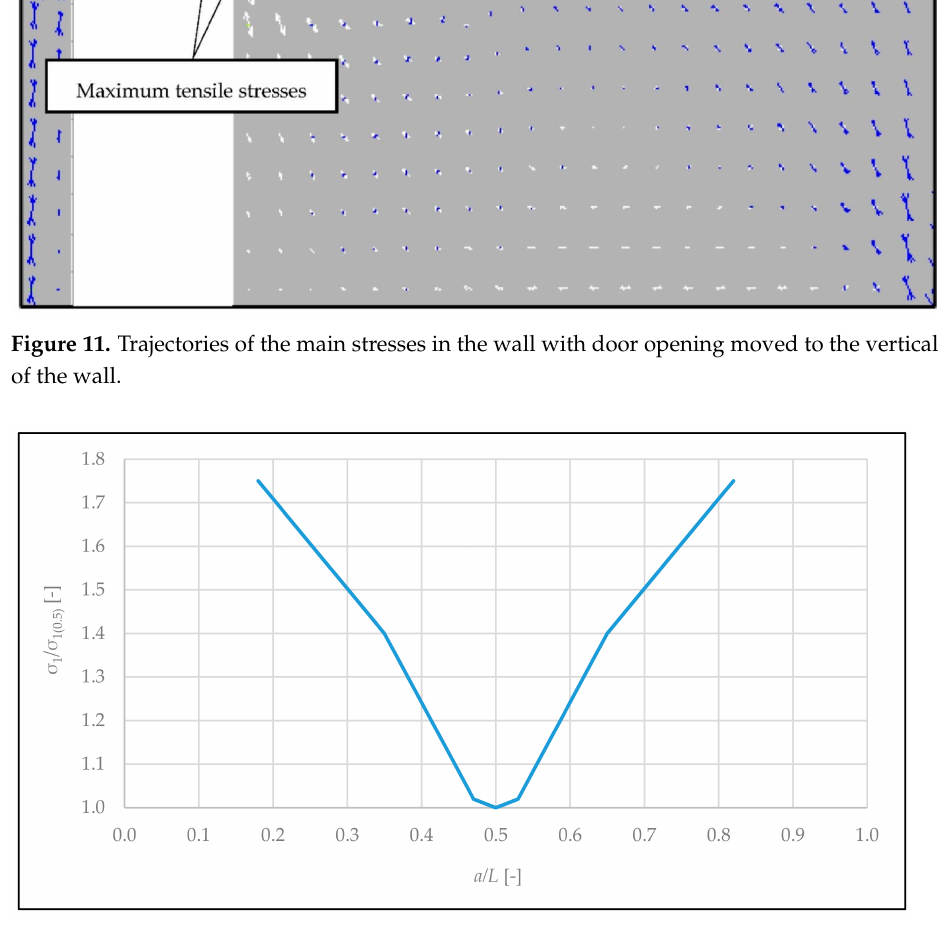
Figure 12. Graph of the dependency between σ 1 / σ 1 (0.5) ratio and door opening localization on the length of the wall. σ 1 (0.5) —main tensile stresses in the zone of the door opening corners, situated in the middle part of the wall ( a / L = 0.5), a —distance from the vertical edge of the wall to the opening center, and L— length of the